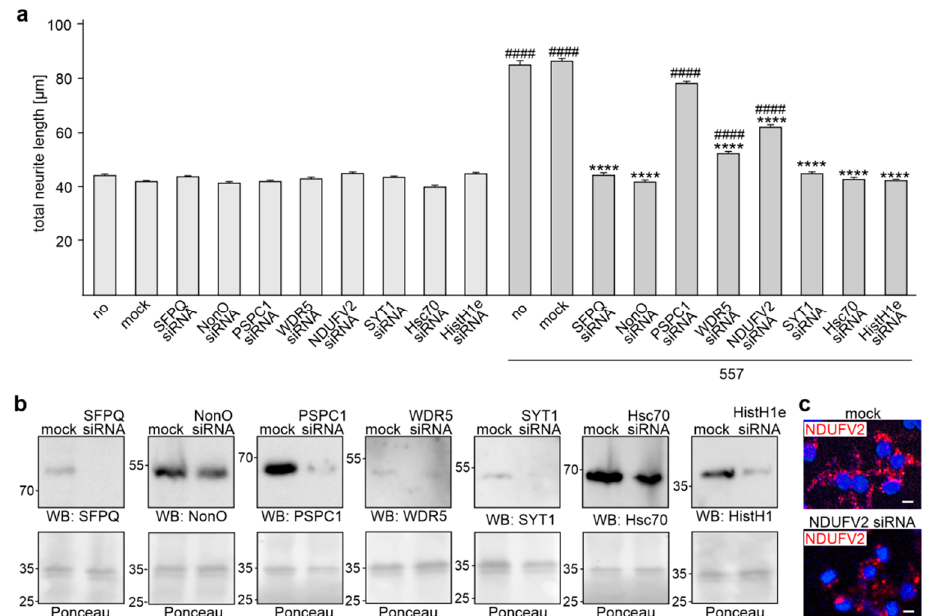
Figure 5. Reduction of SFPQ, NonO, WDR5, NDUFV2, SYT1, Hsc70, and HistH1e expression by siRNAs inhibits L1-dependent neurite outgrowth. Cortical neurons were not treated (no), treated without (mock), or treated with siRNAs specific for SFPQ, NonO, PSPC1, WDR5, NDUFV2, SYT1, Hsc70, and HistH1e. Neurons were then treated without or with antibody 557. ( a ) Mean values + SEM from three independent experiments are shown for total neurite lengths (**** p < 0.0001 relative to L1 antibody-stimulated mock-transfected neurons, #### p < 0.0001 relative to non-stimulated mock-transfected neurons; one-way ANOVA with Dunn´s multiple comparison test). ( b ) Western blot analysis of lysates from mock-transfected neurons or neurons transfected with siRNAs using the corresponding antibodies. Ponceau S staining of a prominent 35-kDa band served as loading control.